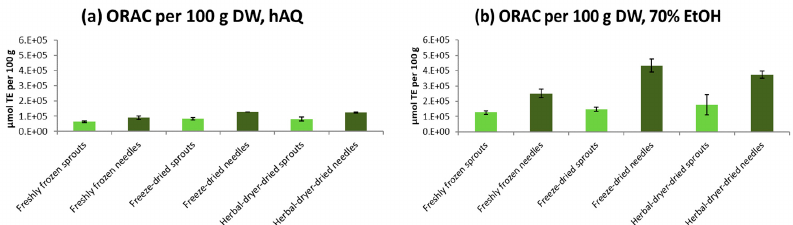
Figure 4. Oxygen radical absorbance capacity (ORAC) of sprout and older needle raw materials (freshly frozen, freeze-dried, warm air-dried) of Norway spruce after water (hAQ) ( a ), and 70% ethanol (70% EtOH) ( b ) extraction. The results are calculated per 100 g dry weight (DW). The error bars indicate standard deviations.